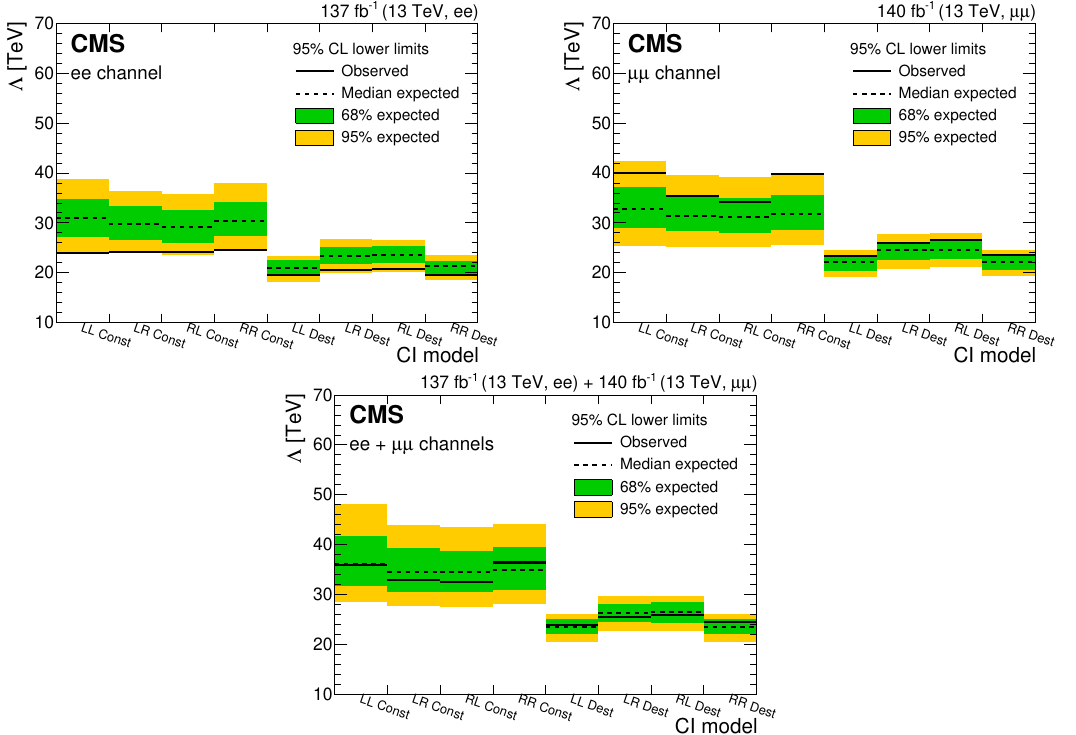
Figure 11 . Dilepton lower exclusion limits at 95% CL on the CI scale ( Λ ) for the eight CI models considered, for (upper left) the dielectron channel, (upper right) the dimuon channel, and (lower) their combination. The limits are obtained for m > 400 ‘‘